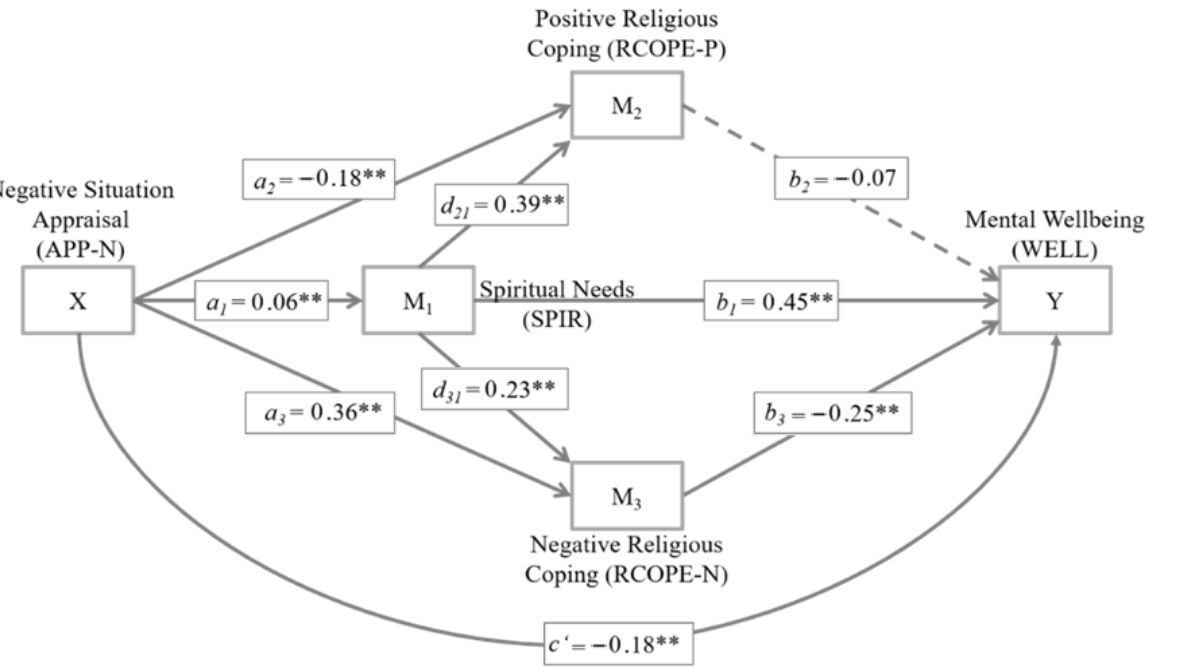
Figure 2. Mediation model with serial and parallel mediation properties to predict mental wellbeing in refugees. Model coefficients are reported in unstandardized form. Solid lines indicate significant paths, dashed lines non-significant paths. The a paths indicate relations between the predictor and the mediators; the b paths indicate relations between the mediators and the criterion; the c’ path indicates the relation between the predictor and the criterion when controlled for the mediators; the d paths indicate the relation between the mediators. ** p < 0.010. Table 3. Model coefficients for the mediation model with serial and parallel mediation